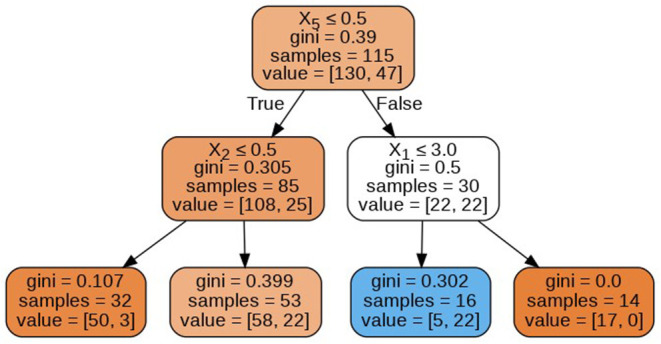
Decision tree 100.